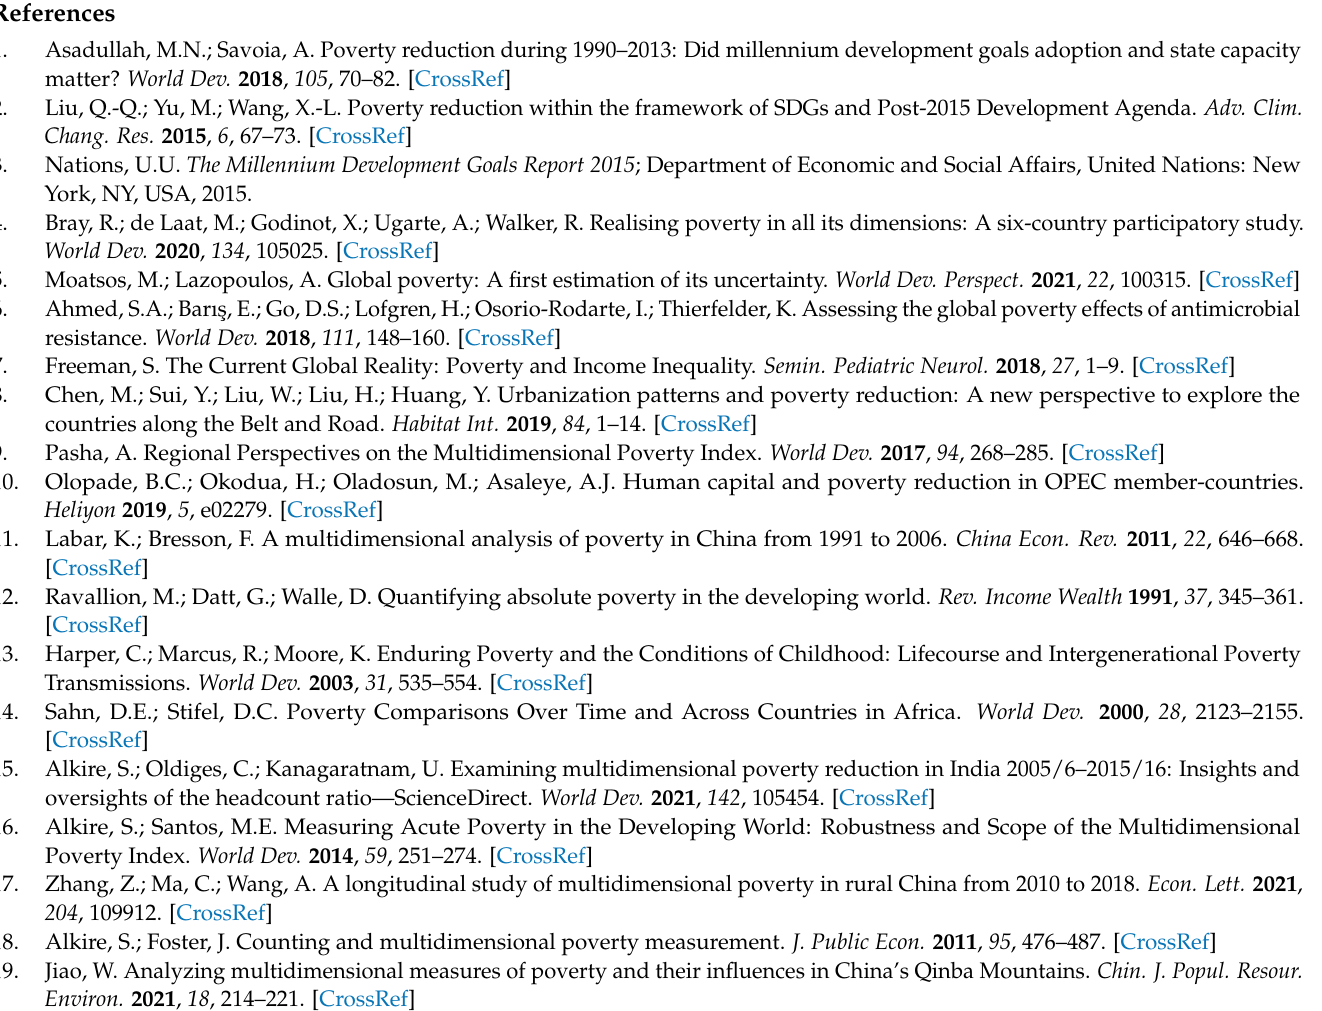
Figure A4. Spatial autocorrelation report of MDI.